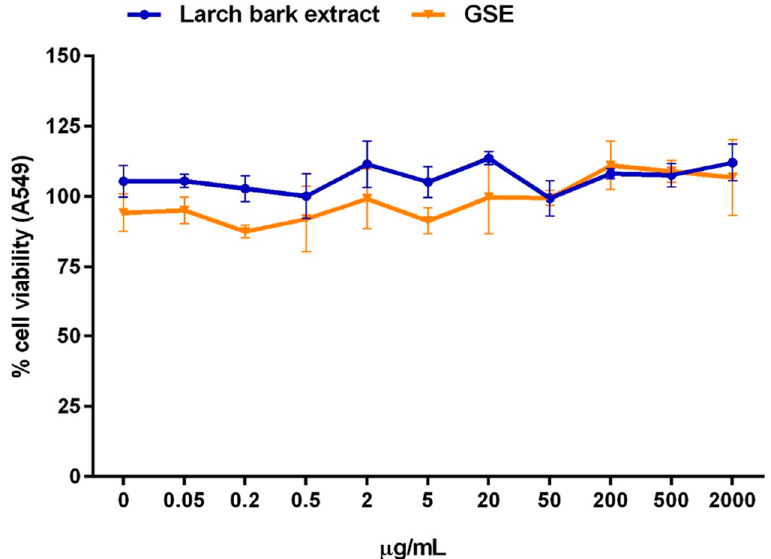
Figure 1. Effect of a 24 h treatment with larch bark extract (blue line) in the concentration range 0– 2000 µg/mL on human A549 cells (adenocarcinomic alveolar basal epithelial cells) viability. A comparison with grapefruit seed extract (GSE; orange line) is reported. Results are the mean ± SD of n = 3 experiments and are expressed as percentage of absorbance of treated cells related to control.